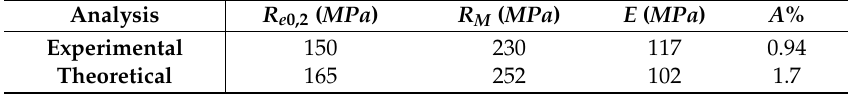
Table 1. Mechanical properties of the hypereutectic RS Al–50%Si alloys. Analysis